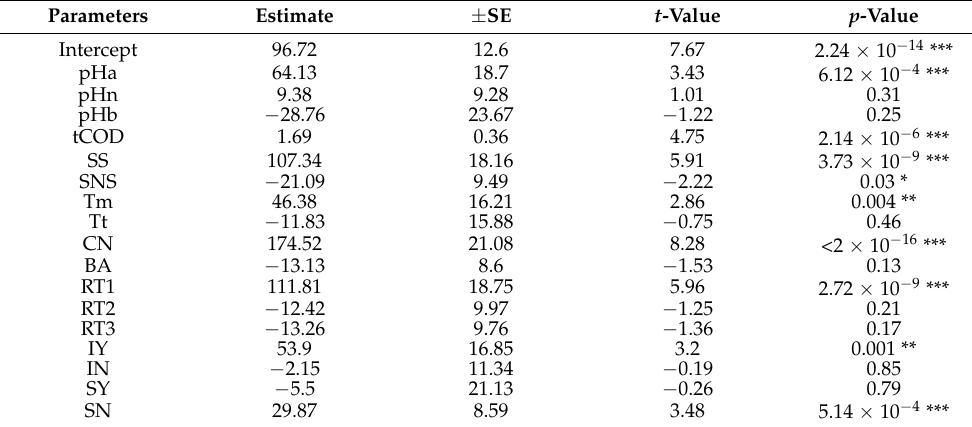
Table 6 shows the correlation between hydrogen productivity and operation parameters. Table 6. Correlation between hydrogen productivity and operation parameters. Symbols annotation: Highly significant ‘***’: 0 ≤ p -value < 0.001; fairly significant ‘**’: 0.001 ≤ p -value < 0.01; significant ‘*’: 0.01 ≤ p -value < 0.05; non-significant ‘ • ’: 0.05 ≤ p -value < 0.1; highly non-significant ‘no symbol’: p -value ≥